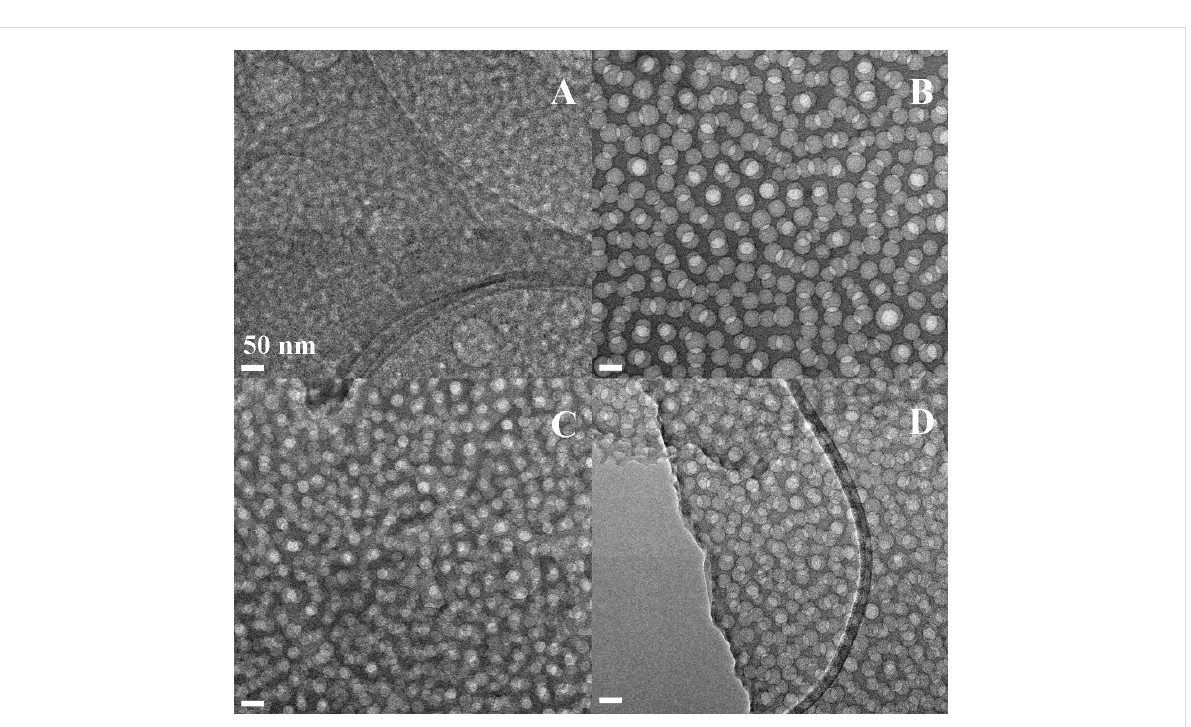
Figure 2: HRTEM micrographs of calcined 93TEOS/7PS- b -PEO films obtained by using different block copolymers, namely: PS 117 - b -PEO 543 (A), PS 183 - b -PEO 145 (B), PS 308 - b -PEO 250 (C), and PS 567 - b -PEO 704 (D). All micrographs were collected at the same magnification. Panel (B) reprinted with permission from [19], copyright 2014